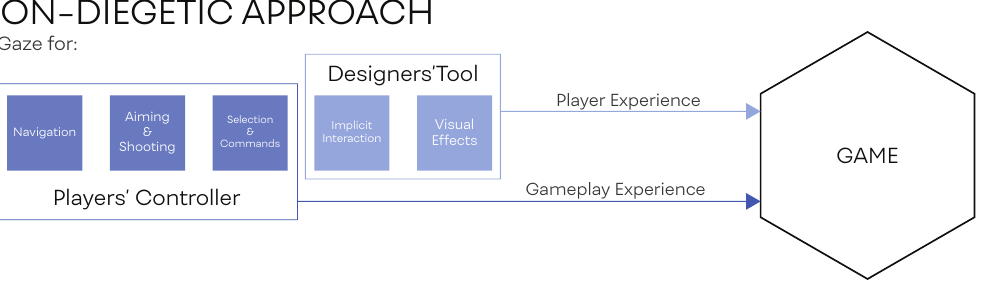
Figure 1. Non-diegetic design approach based on Velloso et al.: Survey